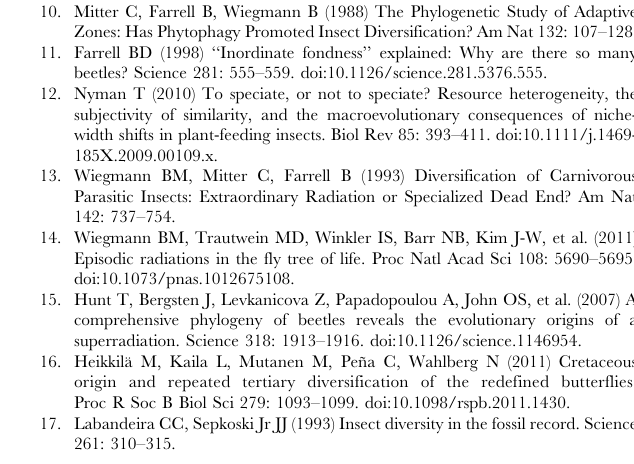
Figure S1 Nodal support on the phylogeny. Nodes marked with circles are either constrained (red) or have high bootstrap support (light blue 50–80%, dark blue: over 80%). Figure S2 Topology showing 95% confidence intervals on node ages (transparent blue bars). Black rings denote 100 Ma intervals from the present. Nodes denoted with red circles are involved in calibration (see Table S2 for details). Figure S3 The fifty shifts with the highest rates of recovery in samples from the MCMC chain (Table S4) plotted together on the tree topology. Shifts are denoted as Fig. 1 with novel shifts not recovered on the mean tree denoted by red circles. Groupings on the ring and other information are as Fig.1. Table S1 Estimates of extant species richness for terminal groups and GenBank accession numbers for sequences used in phylogenetic reconstruction. Table S2 Fossil calibrations implemented in dating the tree topology. Calibrated nodes are plotted on Fig. S2. Where available, radiometric date estimates are referenced on the first occurrence of the deposit. Alternatively, the relevant stage